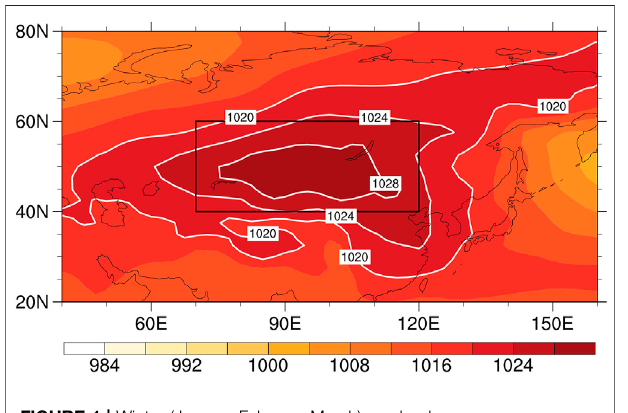
FIGURE 1 | Winter (January-February-March) sea level pressure climatology. Reference period is 1981 – 2010. Only pressures exceeding 1020hPa are shown as white lines. The values of SLP for the box region are averaged to de fi ne the intensity index of the winter Siberian High.